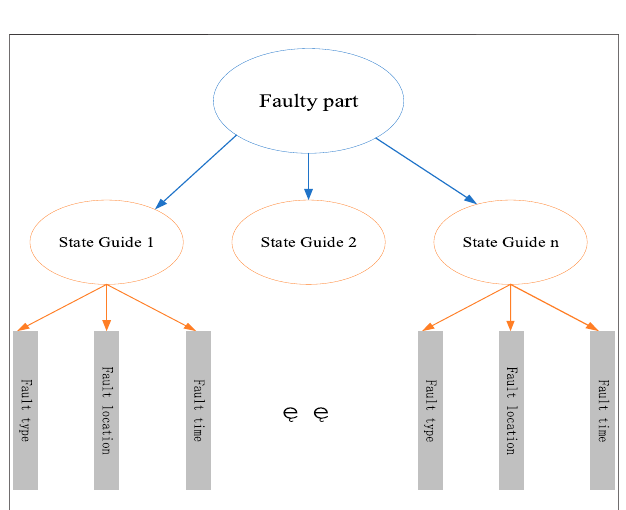
FIGURE 2 | The construction mode of the knowledge graph data